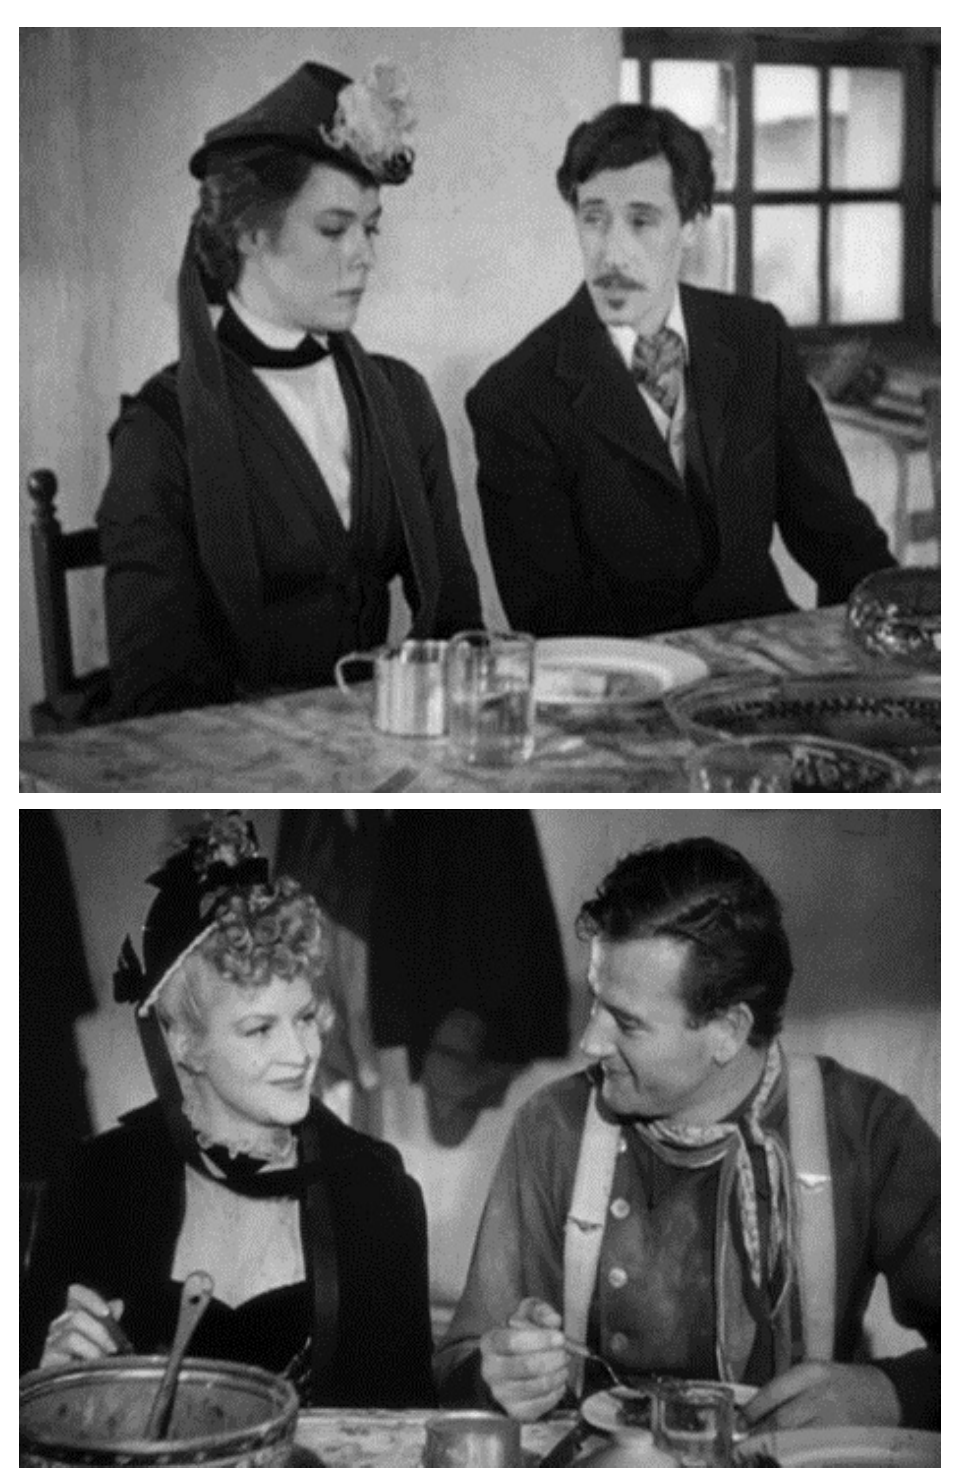
Figure 7: The successive two shots that embody the mythic argument of the film. The cold, formal hierarchy of the old southern code is replaced by the new, warm, western